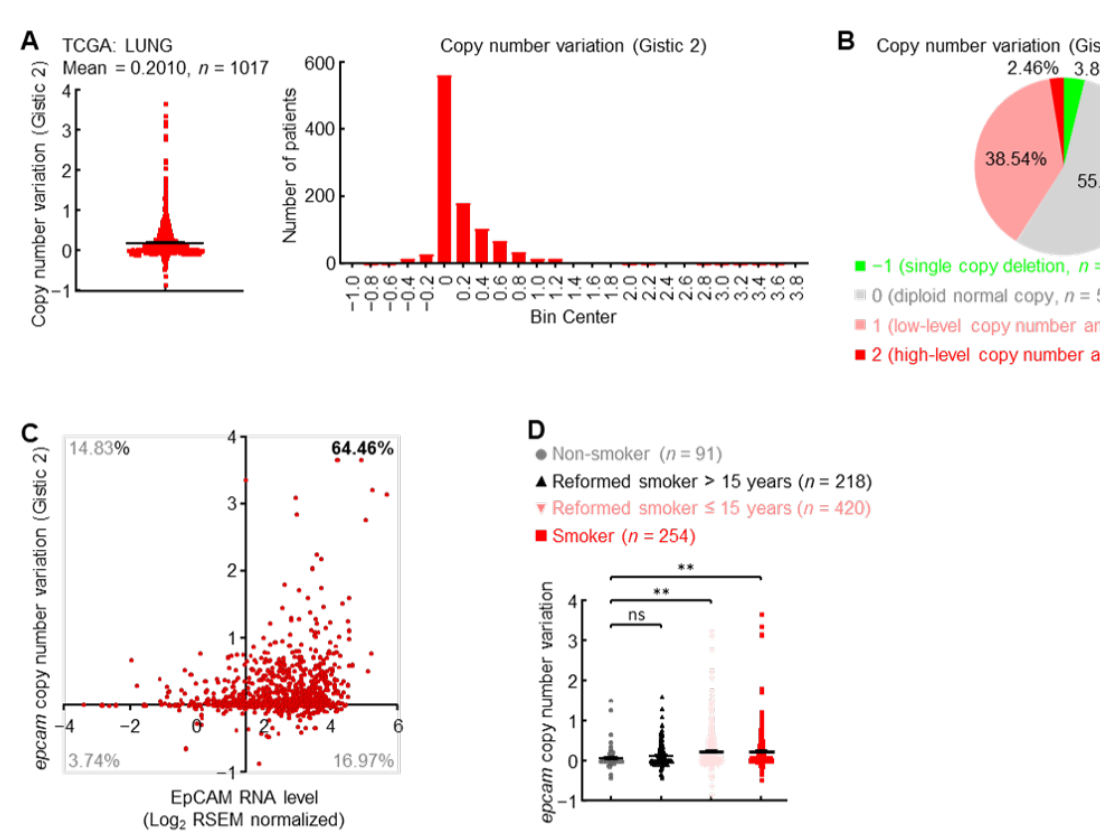
Figure 2. Gene amplification induces EpCAM expression in primary lung cancer. ( A ) TCGA LUNG Gistic 2 data showing epcam gene amplification in human primary lung cancer. ( B ) TCGA LUNG Gistic 2 thresholded data showing distribution of epcam copy number variation in human primary lung cancer. ( C ) TCGA LUNG data showing epcam gene amplification in about 64% of lung cancers with increased EpCAM expression. Axis x and y cross at mean value (1.45, 0) of EpCAM expression level and copy number variation in normal lung. ( D ) TCGA LUNG data showing positive association between smoking and epcam gene amplification. Student’s t test (two-tailed, unpaired) was performed. Data represent means ± SEM ( D ). ** p < 0.01; ns, not statistically different.